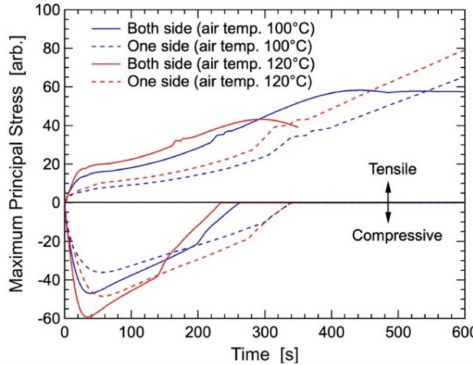
Figure 10. Transient behavior of maximum principal stresses in sample with 1.0-mm